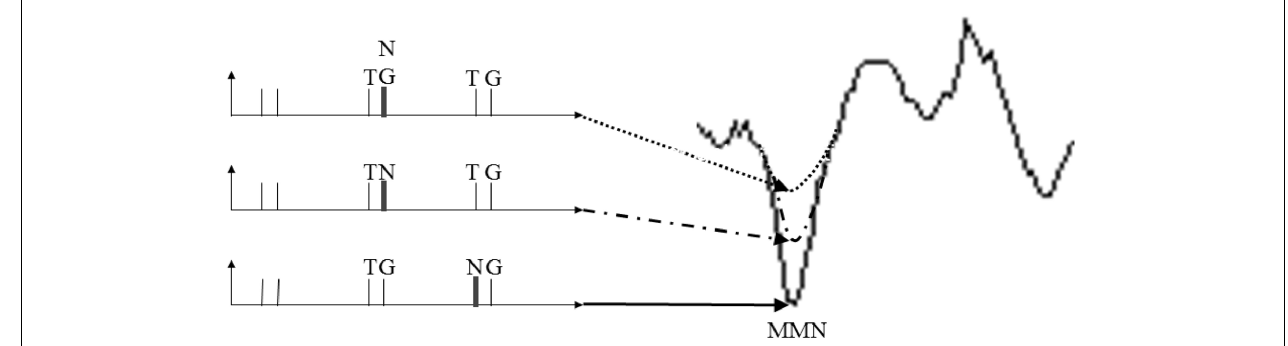
FIGURE 12 | The context interpretation about MisMatch Negativity in schizophrenic